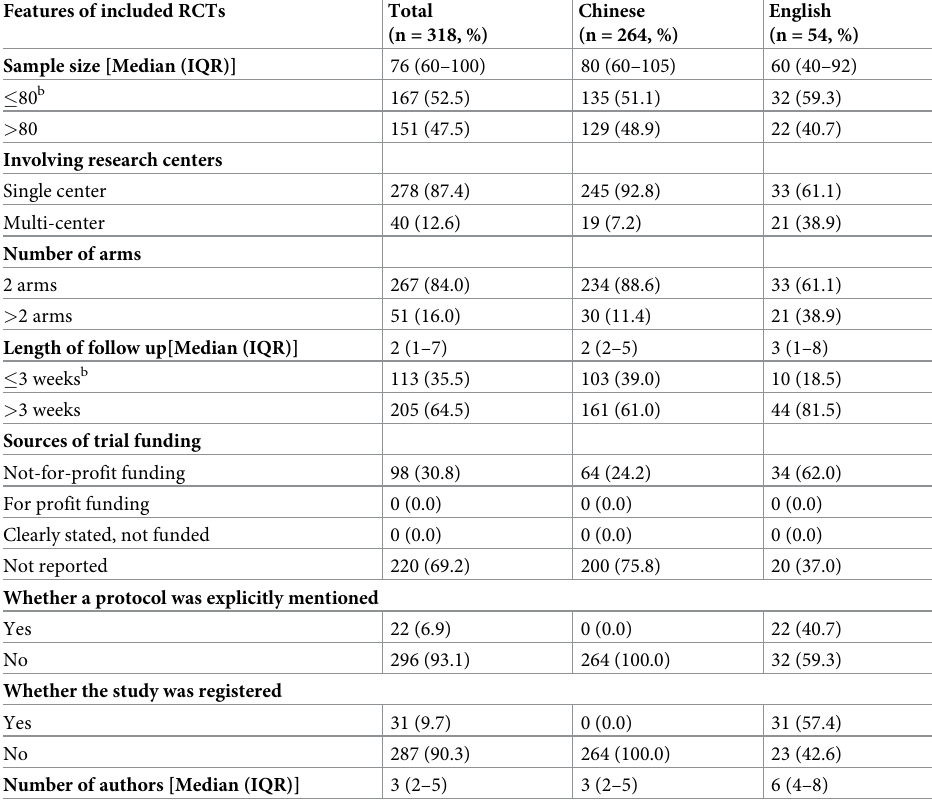
Table 1. General characteristics of included